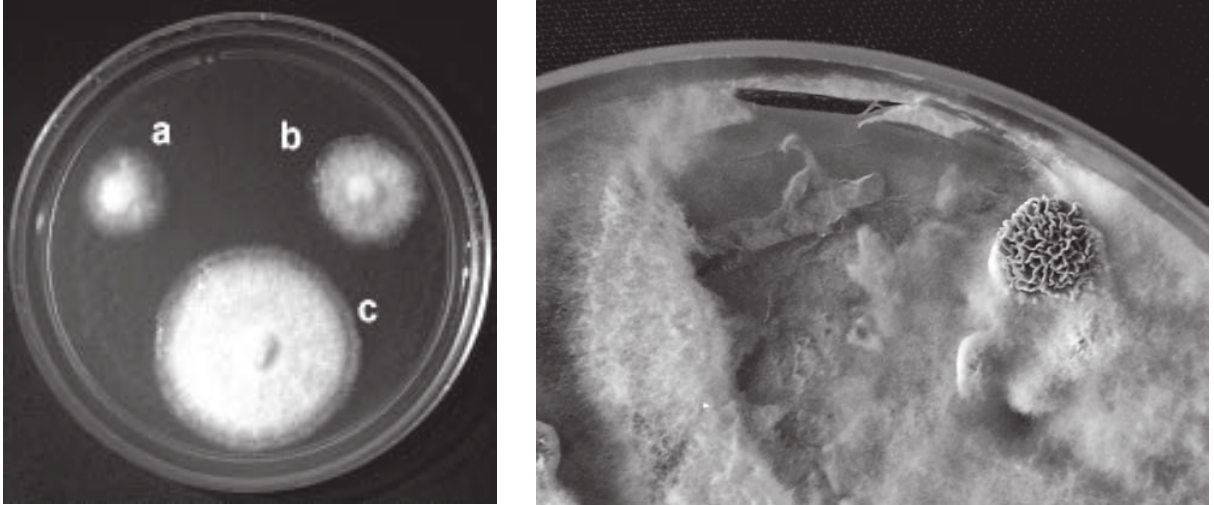
Fig. 2. Monokaryons and dikaryon (left). Monokaryon a, MVHC 11798 from E. globulus and monokaryon b, MVHC 11772 from V. vinifera ; dikaryon c, obtained from pairing a and b. Fruit body formed from the dikaryon (right).